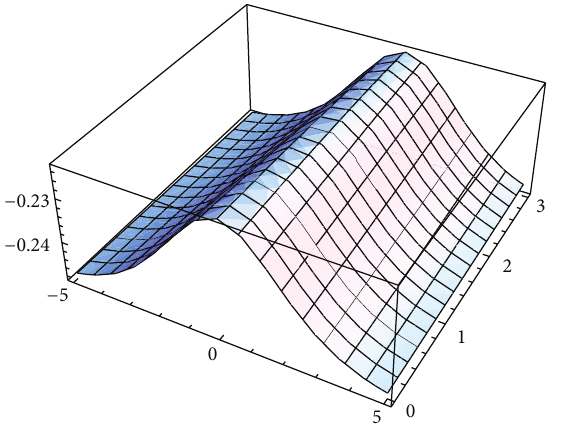
Figure 2: Travelling waves solutions (30) are plotted: bright solitary waves.